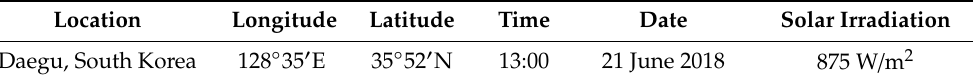
Table 1. Solar load conditions.